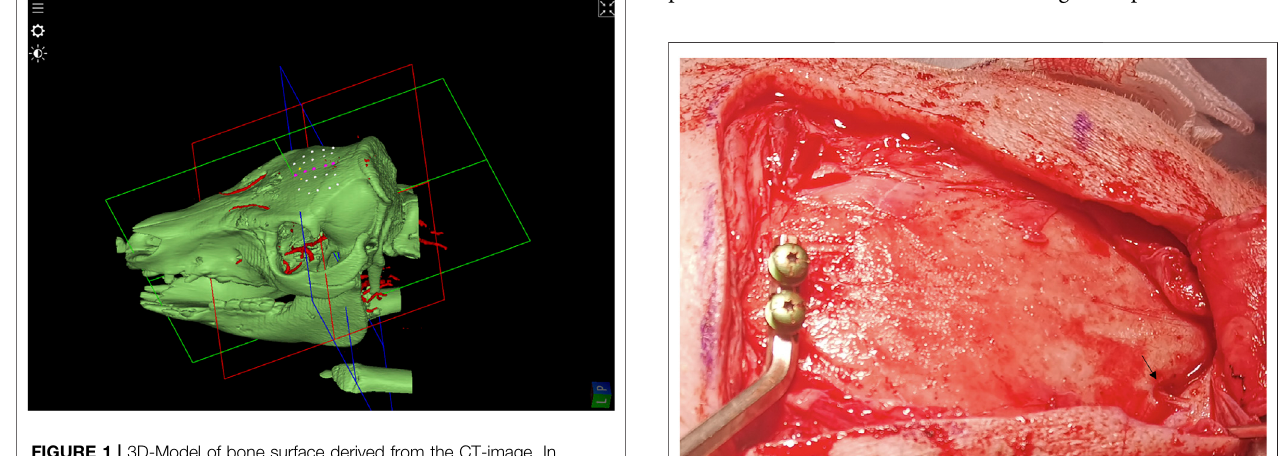
FIGURE 1 | 3D-Model of bone surface derived from the CT-image. In addition, after image registration, blood vessels extracted from Angio-MR data were visualized in red. SEEG-trajectory planning in the upper portion of the pig ’ s skull are shown in white avoiding blood vessels and in purple passing vessels and in yellow under an angle of around 45 ° .